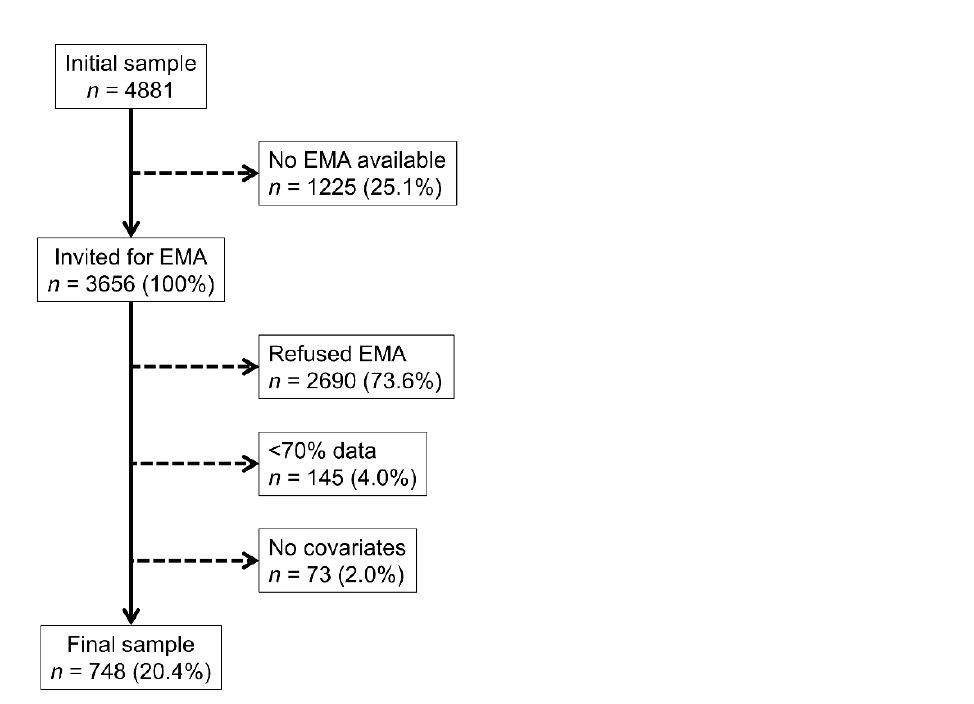
Figure 1. Selection procedure, CoLaus|PsyCoLaus study, Lausanne, Switzerland, 2015–2017.